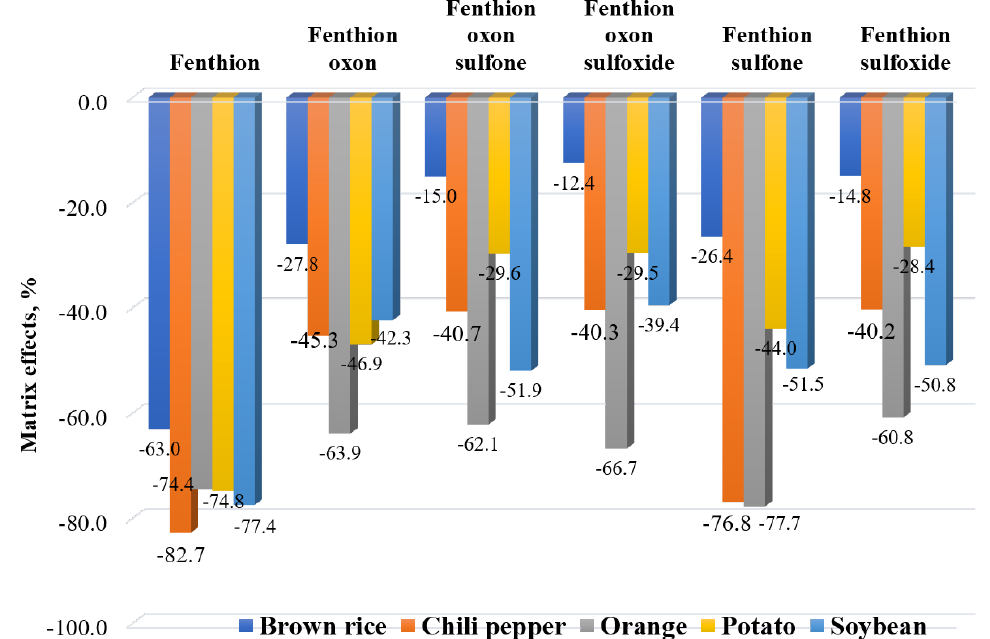
Figure 6. Distribution of the matrix effects in the different commodities and compounds.